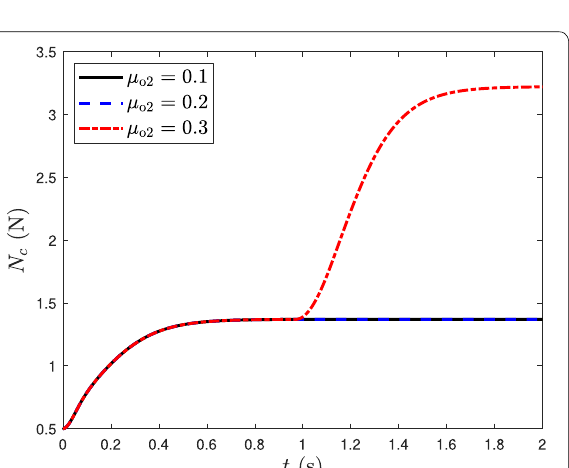
Fig. 14 Control torques of the finger joints